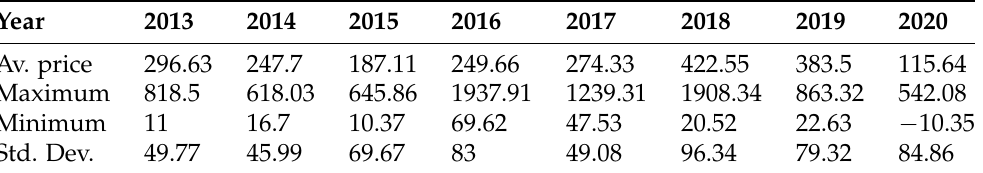
Table 6. Average system price in the Nordic electricity market (NOK per MWh). Maximum, mini- mum, and standard deviation in the period of 2013–2020.